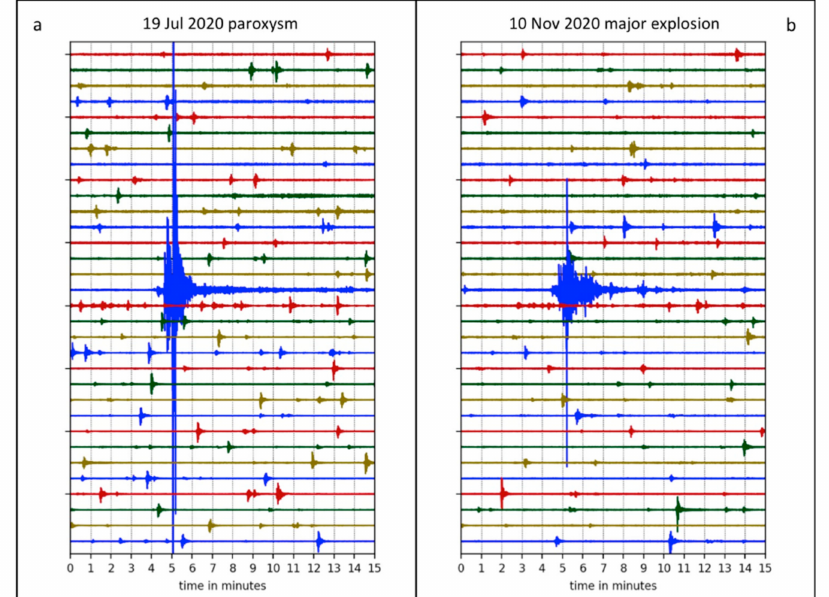
Figure 16. Comparison between the seismograms of a paroxysm ( a , 19 July 2020) and a major explosion ( b , 10 November 2020). Both plots ( a and b ) represent an 8-h signal recording of the east-west component of the STRA station (see Figure 1 for station location). The small amplitude transients that are recognizable in both plots are due to the ordinary Strombolian